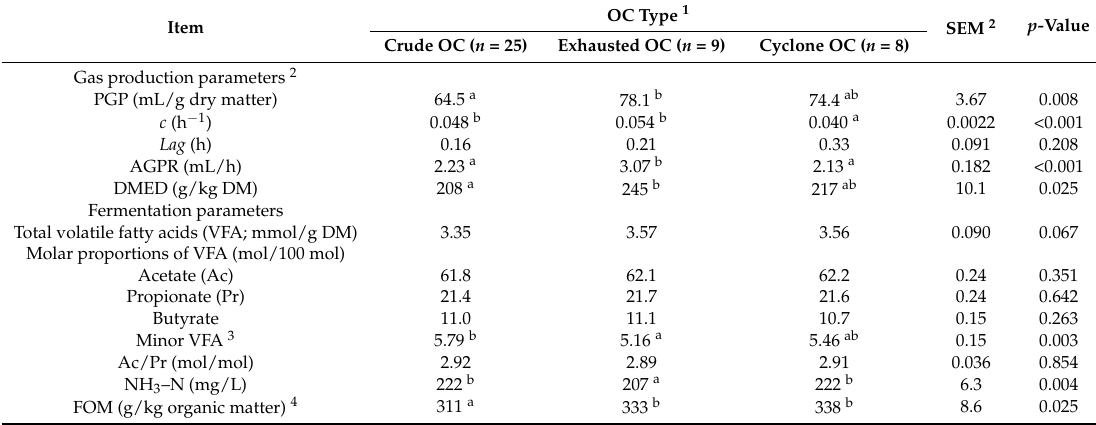
Table 3. Influence of olive cake (OC) processing on gas production parameters, dry matter